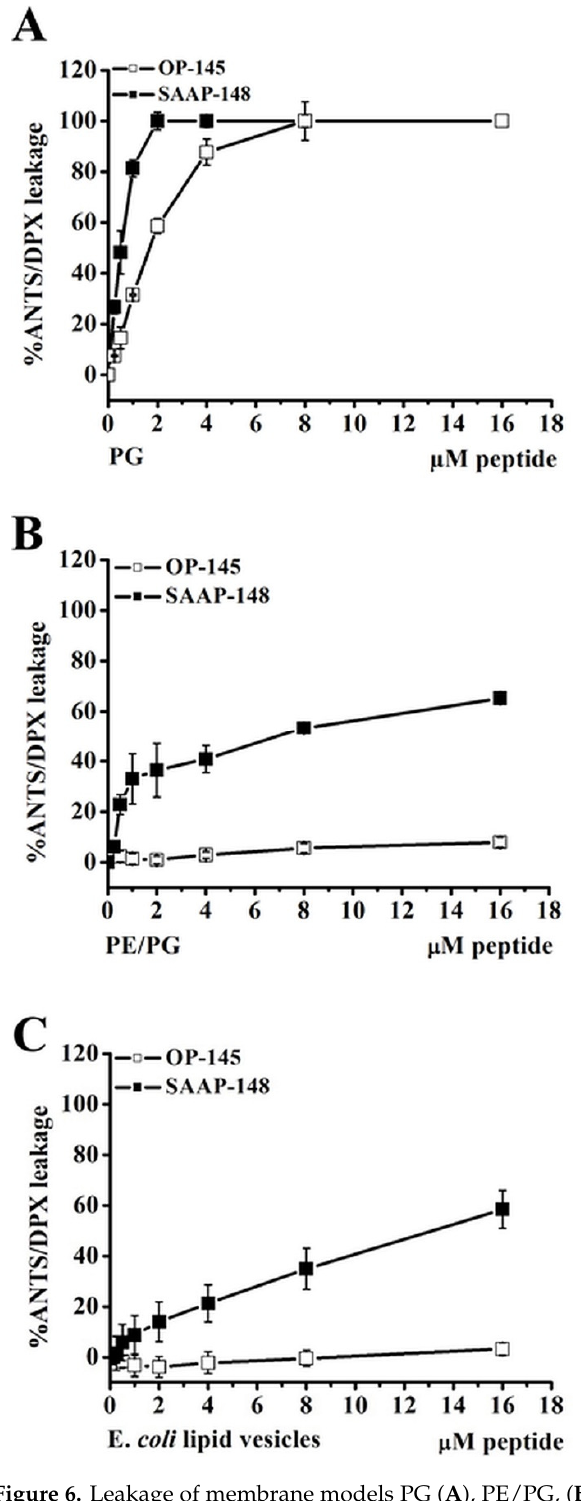
Figure 6. Leakage of membrane models PG ( A ), PE/PG, ( B ) and E. coli polar lipids ( C ) in absence and presence of OP-145 (squares) and SAAP-148 (circles) at indicated concentration ranging from 0.25 to 16 µM for membrane model which corresponds to lipid to peptide molar ratio of 200:1-3.125:1. Data points are averages ± standard deviations of three independent experiments.